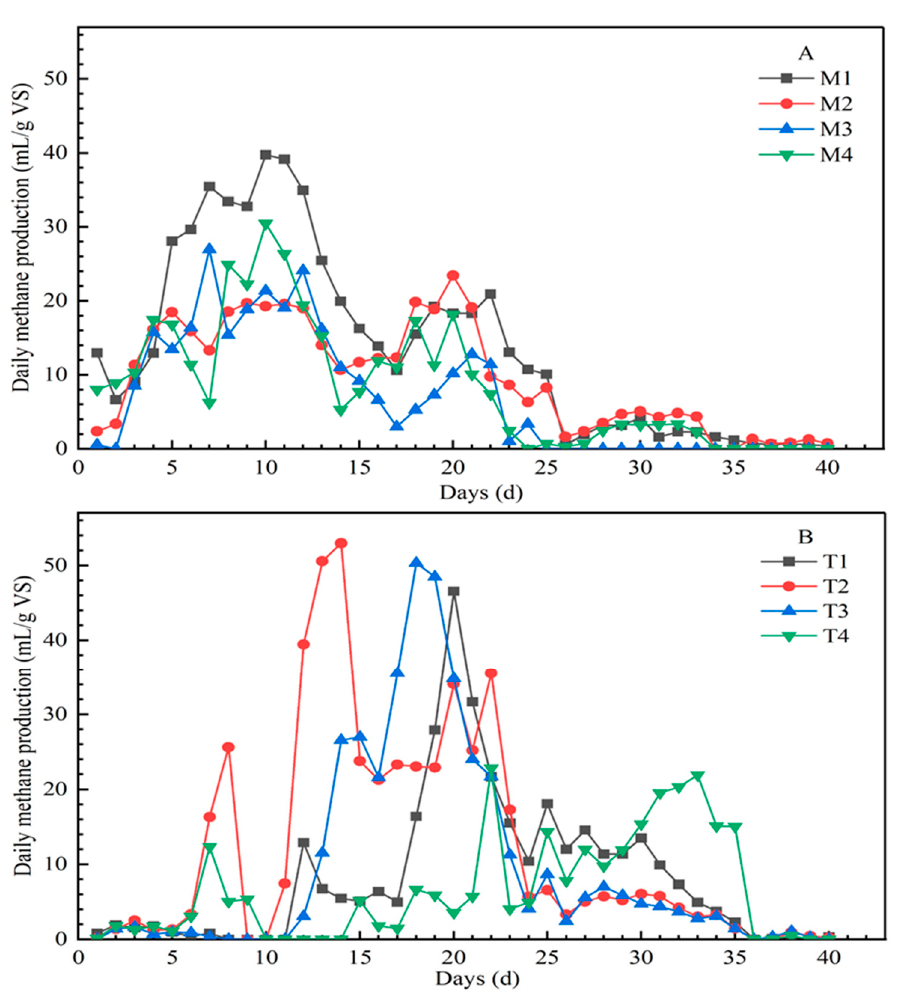
Figure 1. Daily methane production from different mixtures of substrates under mesophilic condi-